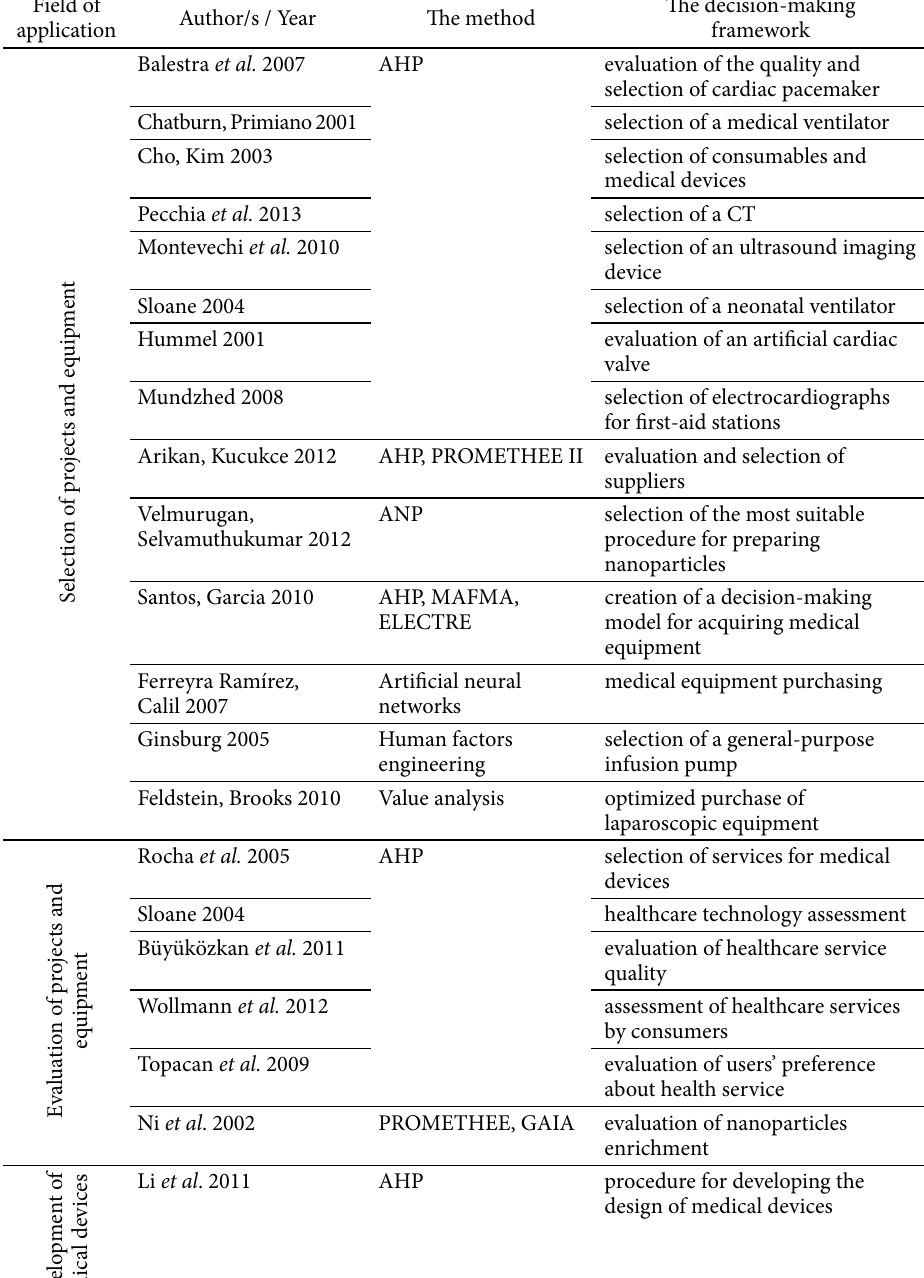
Table 2. MCDA applications for medical equipment management Field of